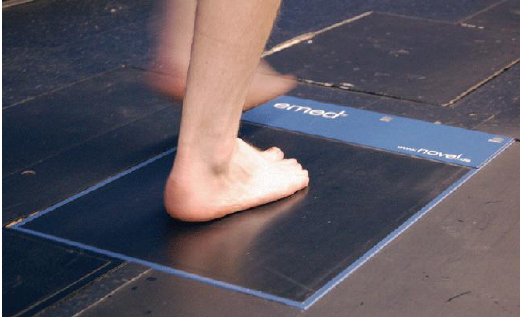
Figure 1. A platform-based foot plantar pressure sensor emed ® by Novel [24].